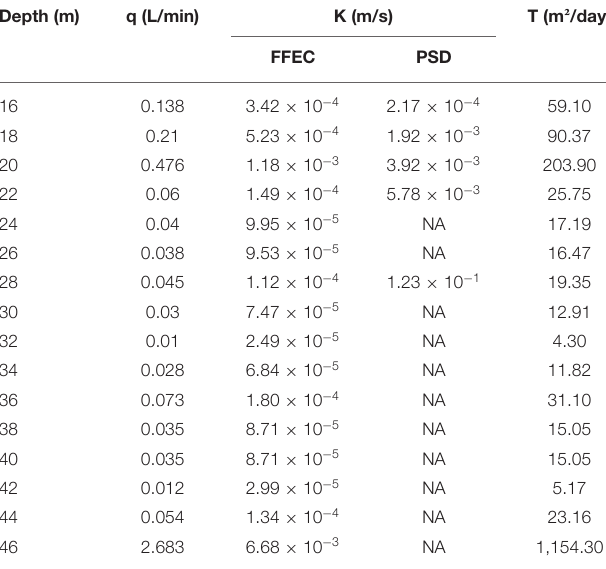
TABLE 2 | Flow strength ( q ) and concentration ( C ) obtained from BORE II modeling and estimated transmissivities, K from flowing fluid electrical conductivity (FFEC) modeling, and approximated using Eq. 1 and particle size distribution (PSD) for the Nalanda University Campus (NUC)